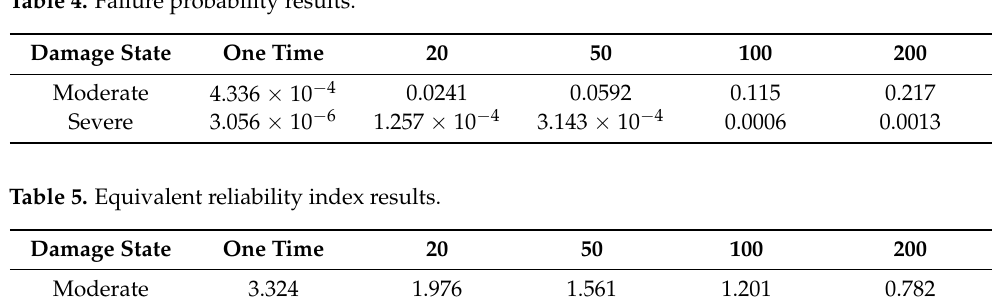
Table 4. Failure probability results.